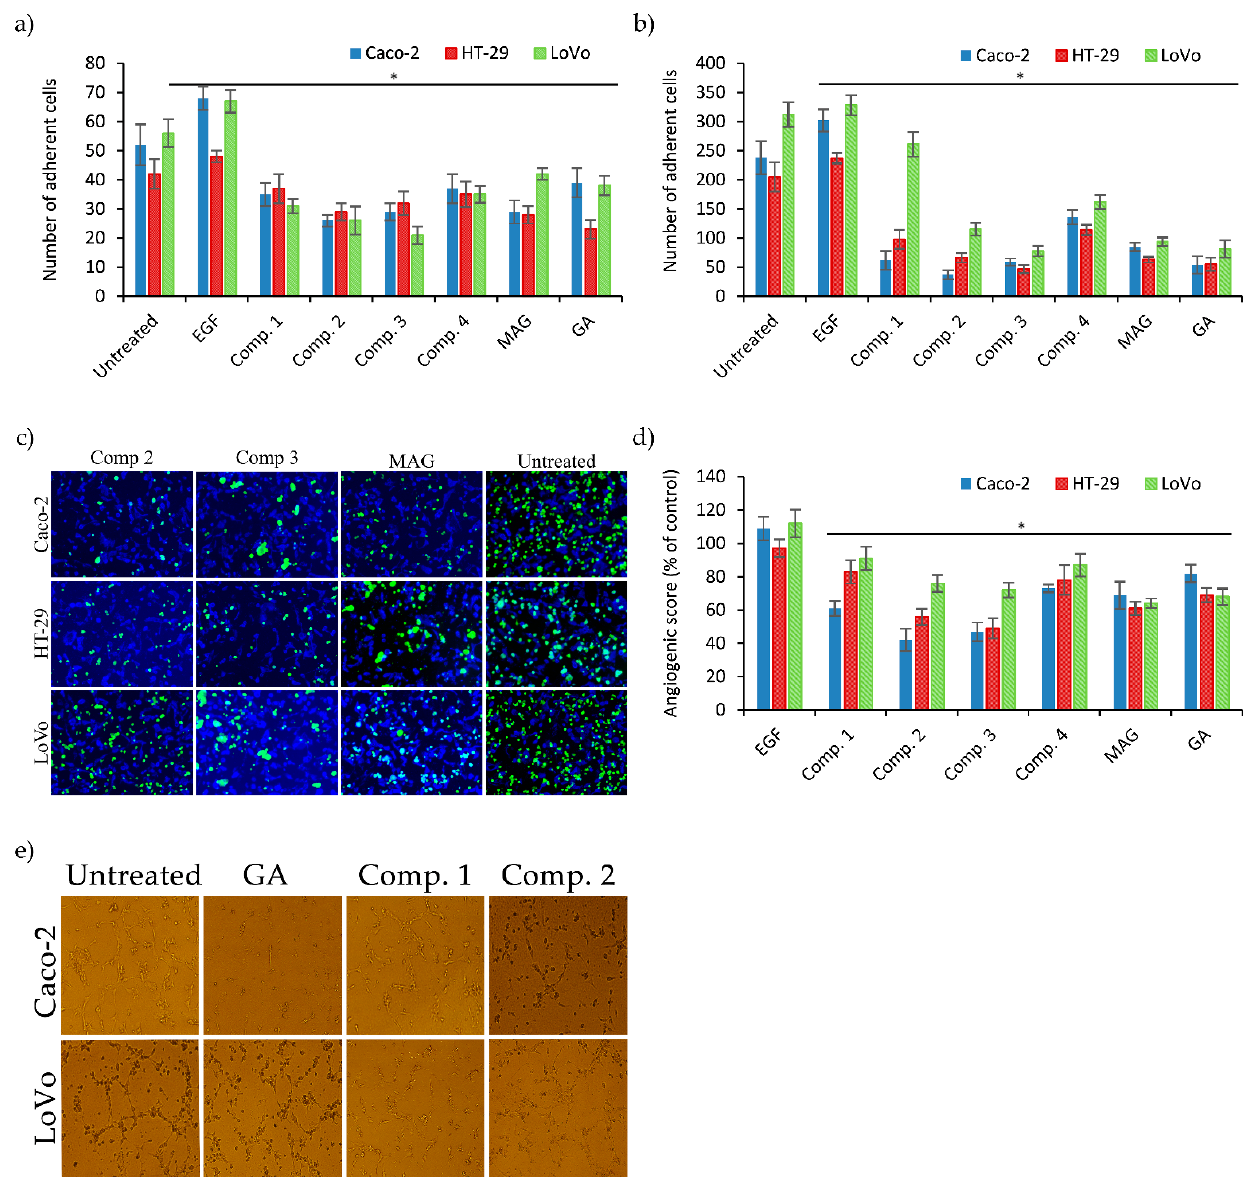
Figure 3. Cell–environment response after xanthone treatment. ( a ) Results of Matrigel adhesion assay. EGF served as positive control. ( b ) Quantification of tumor cell adhesion to endothelium. ( c ) Representative images of tumor cells (green fluorescence) adhered to HMEC-1 (blue fluorescence) monolayers (mag. 200×). ( d ) Results of capillary tube formation assay. Graph presentation of angiogenic score of Caco-2, HT-29, and LoVo cell lines after xanthone treatments. Results are expressed as the change in angiogenic score with respect to untreated controls. EGF was used as positive control (+). ( e ) Representative images of tube assay (mag. 200×). Graphs present mean (+/ − S. D.) values; * indicates a significant difference ( p < 0.05) vs. untreated controls.